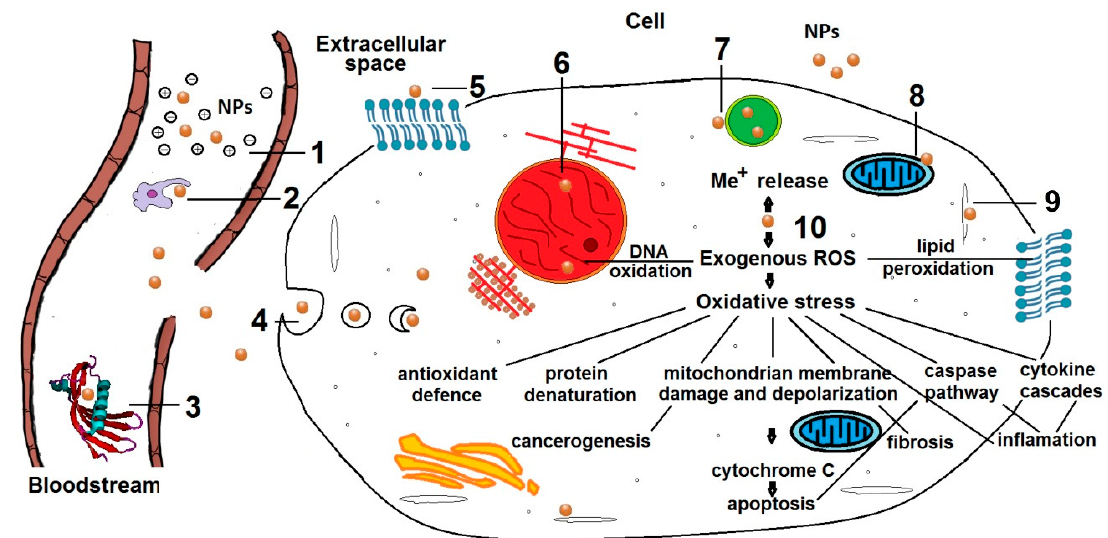
Figure 2. Mechanisms of metal oxide nanoparticles (MONPs) delivery pathway and cell damage in eukaryotic cells: ( 1 ) interaction with ions in circulation; ( 2 ) ingestion by phagocytic cells; ( 3 ) opsonization or enzymic degradation; ( 4 ) internalization via endocytosis after extravasation to the extracellular space or ( 5 ) membrane perforating and damage of its components and their function; ( 6 ) chromosomal aberrations and changes in cell replication rate; ( 7 ) lysosome rupture; ( 8 ) mitochondria damage; ( 9 ) lower growth rate, structural changes and shorten lifetimes of microtubules of the cytoskeleton; ( 10 ) generation of ROS, oxidative stress and subsequent processes. The fate and cytotoxic effects of the MONPs may include: